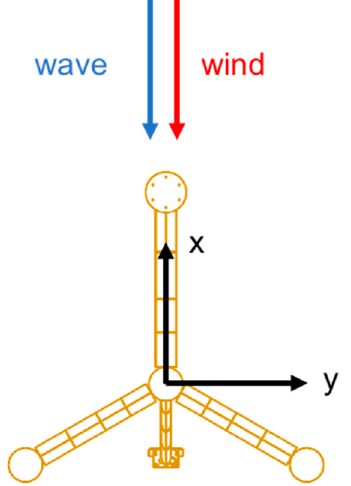
Figure 6. Wave and wind angle incidences.